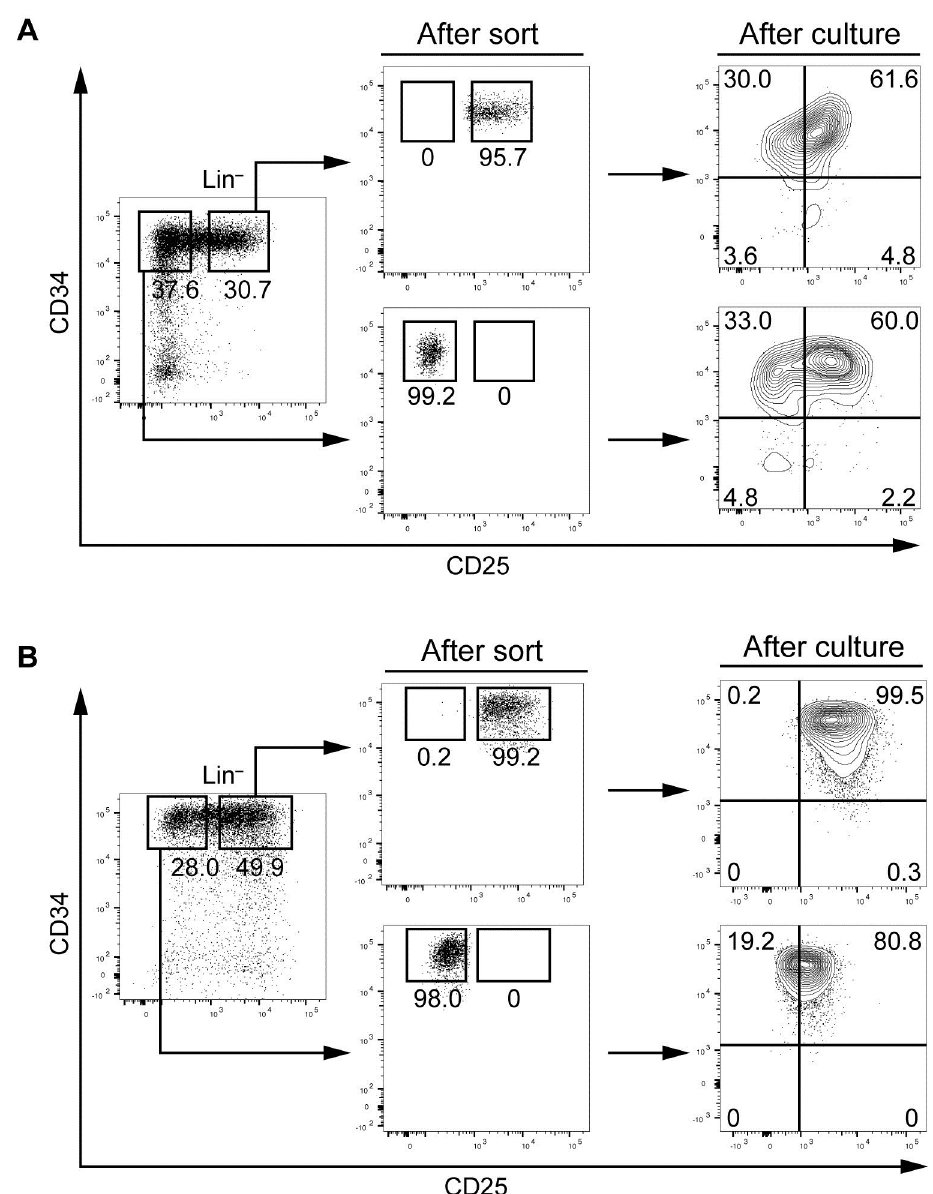
Fig 4. Cell culture of CD25-positive and -negative CD34 + cells from CD25-positive AML. CD25-positive and -negative CD34 + cells from AML01 and 05 were isolated and cultured for 48 hours at a concentration of 3 × 10 5 /ml in 12-well plates in the presence of IL-3, G-CSF, GM-CSF, EPO, TPO, and